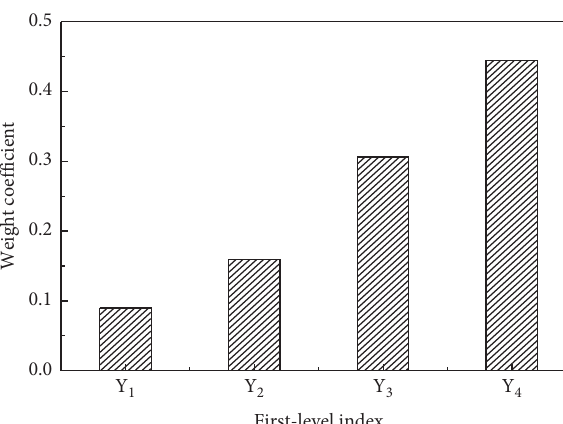
Figure 2: The weight coefficient of primary layer index on the assessment of college E&I education